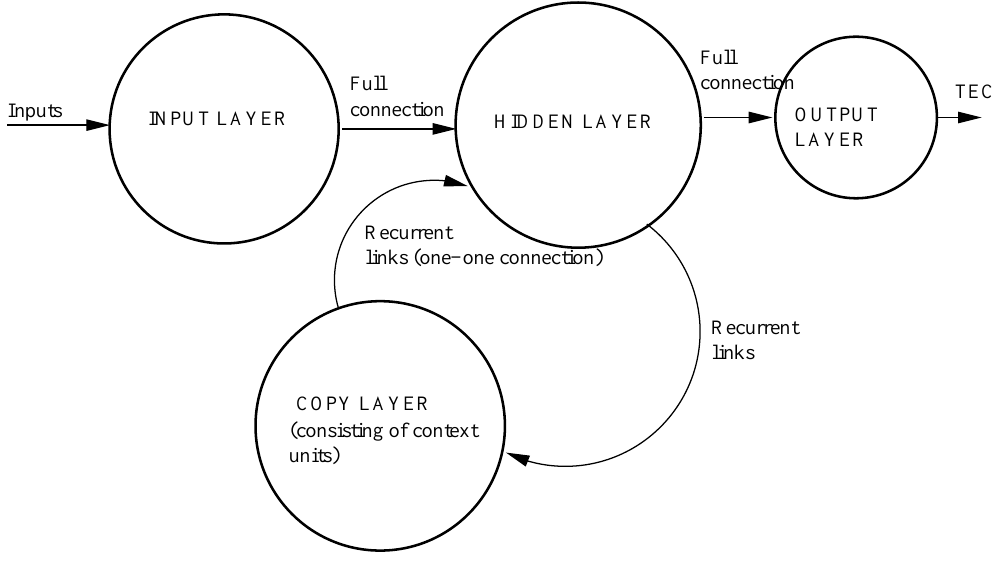
Fig. 1. An Elman neural network structure having one input, one hidden and one output layers.